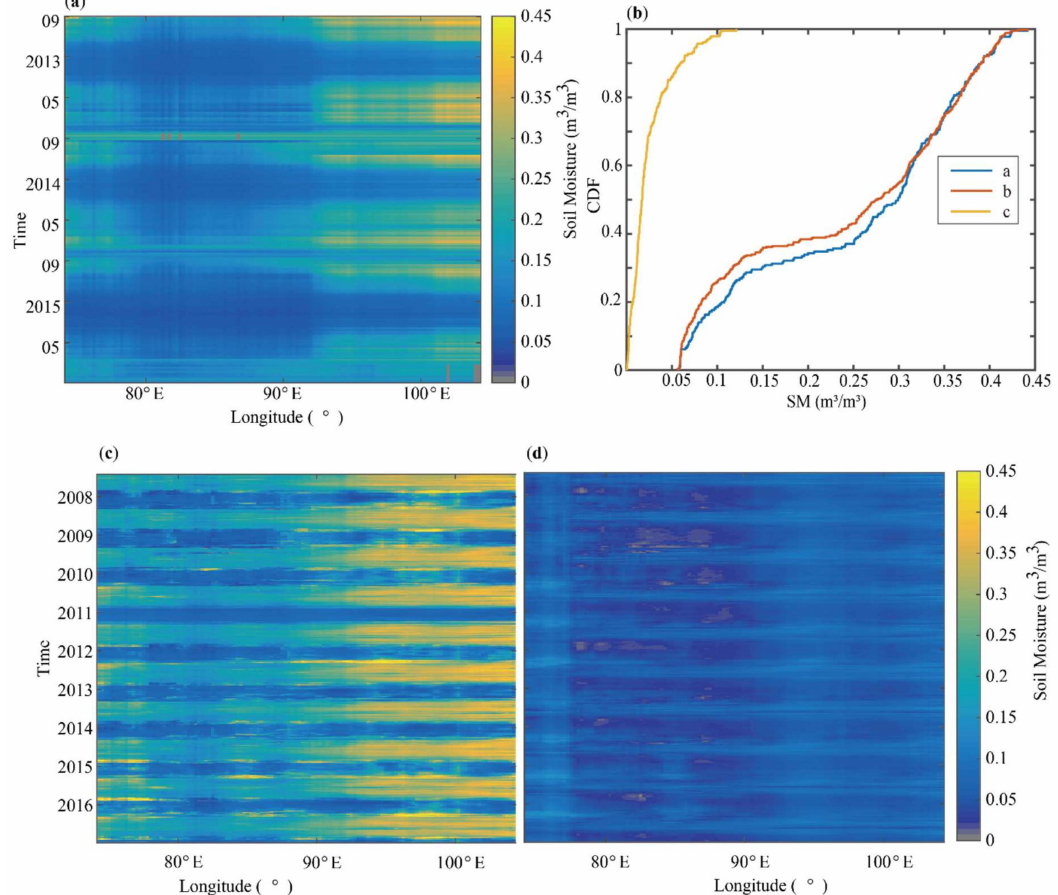
Figure 4. Time-longitude Diagrams of surface soil moisture (SSM) products: ( a ) In-situ data over the Calibration Period; ( b ) the Cumulative Distribution Function (CDF) matching example at the location of the in-situ station of sub-humid region; ( c ) scaled European Centre for Medium-Range Weather Forecasts (ERA)-Interim data; and, ( d ) original ERA-Interim data over the Product